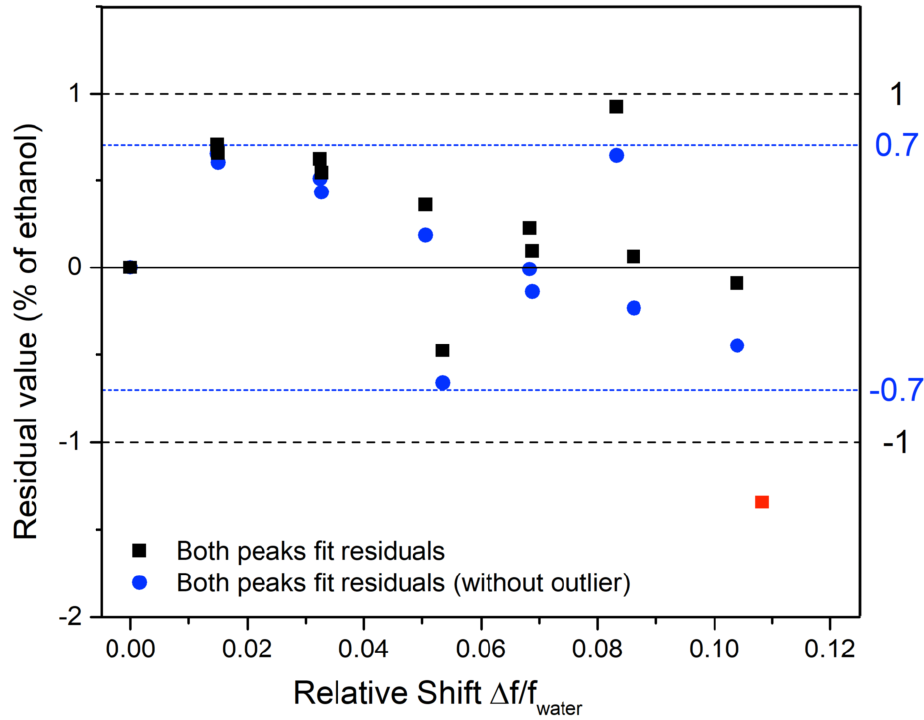
Figure 7. Fitting residuals for the linear fit of both peaks.